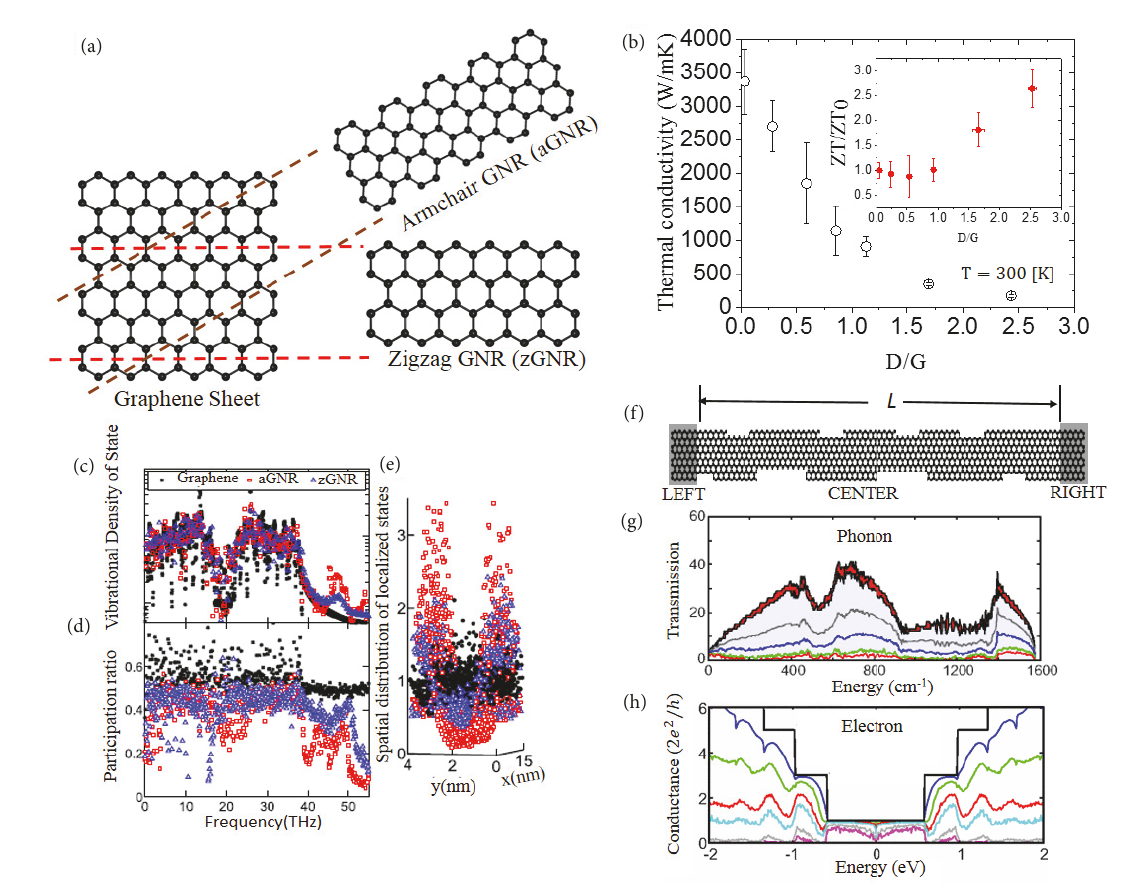
Figure 5: (a) Schematics of the lattice structures of graphene and graphene nanoribbon. (b) Defect density dependence of the thermal conductivity of suspended graphene [74]. The inset shows ZT of defected graphene normalized by that of pristine graphene with respect to D/G at room temperature. D/G ratio is used in Raman spectroscopy to denote the defect density. (c)–(e) The vibrational density of states, phonon participation ratio, and spatial distribution of localized modes in bulk graphene, aGNR, and zGNR [56]. In particular, the height in (e) corresponds to the magnitude of localization at that position. (f) Schematic of edge-disordered zGNR of length L sandwiched between two semiinfinite pristine zGNRs. ((g) and (h)) Phonon transmission and electron conductance for pristine and edge-disordered zGNR with a width of 20 dimer lines, respectively [75]. Panels (c)–(h) are reproduced with permission [56, 75].